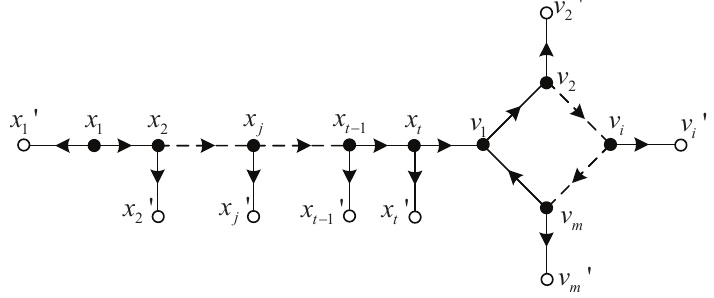
Fig. 4: A removable